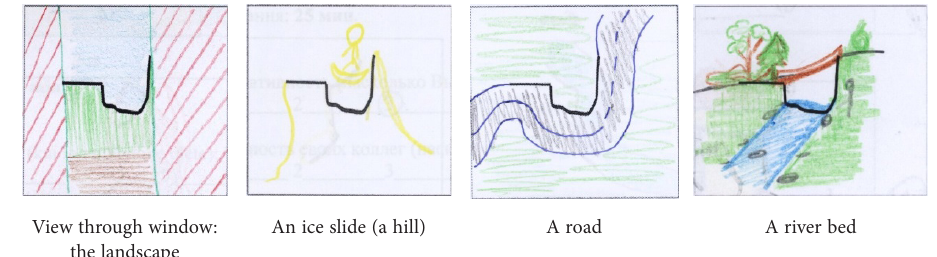
Figure 4. The creative task: interpretation of Fragment 1 – nature views (source: testingmom.com, 2020)